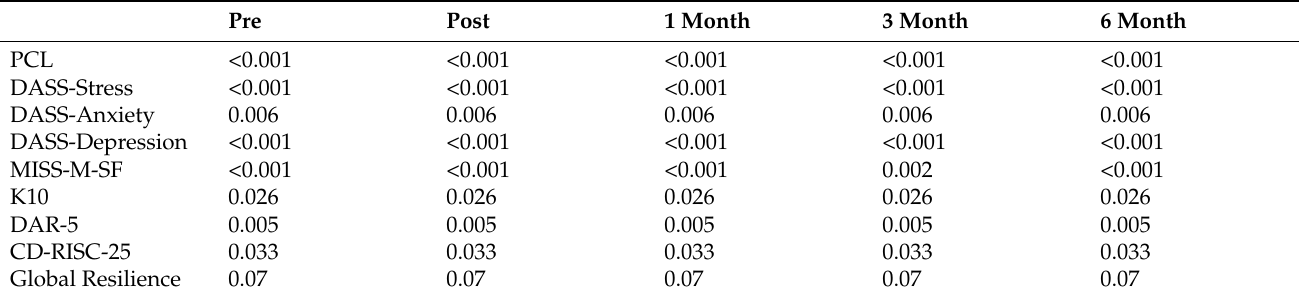
Table 3. Self-report survey